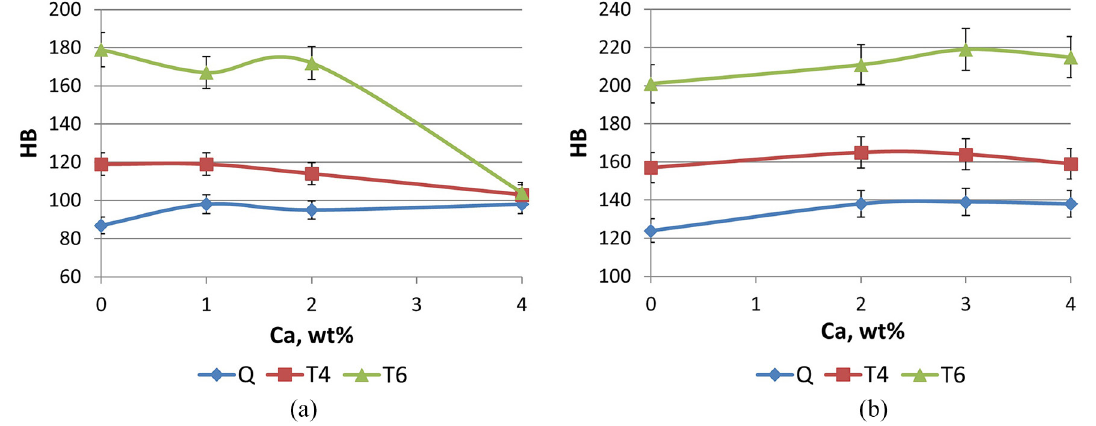
Figure 8. Influence of Ca on hardness for the alloys with different zinc content: (a) 6%Zn; (b) 12%Zn.